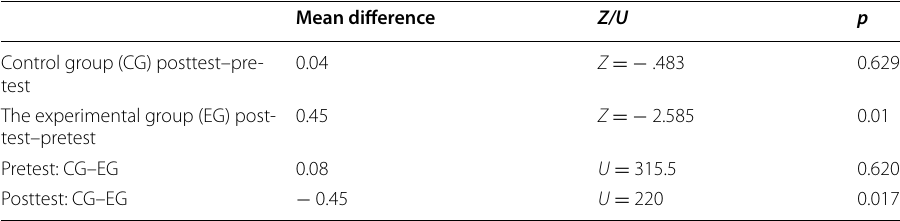
Table 8 Comparisons of the lexical resources scores